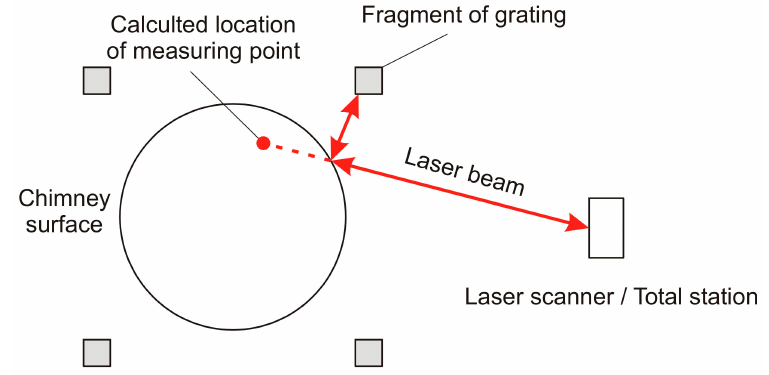
Figure 5. Phenomenon diagram of measuring point appearing “inside” the chimney.